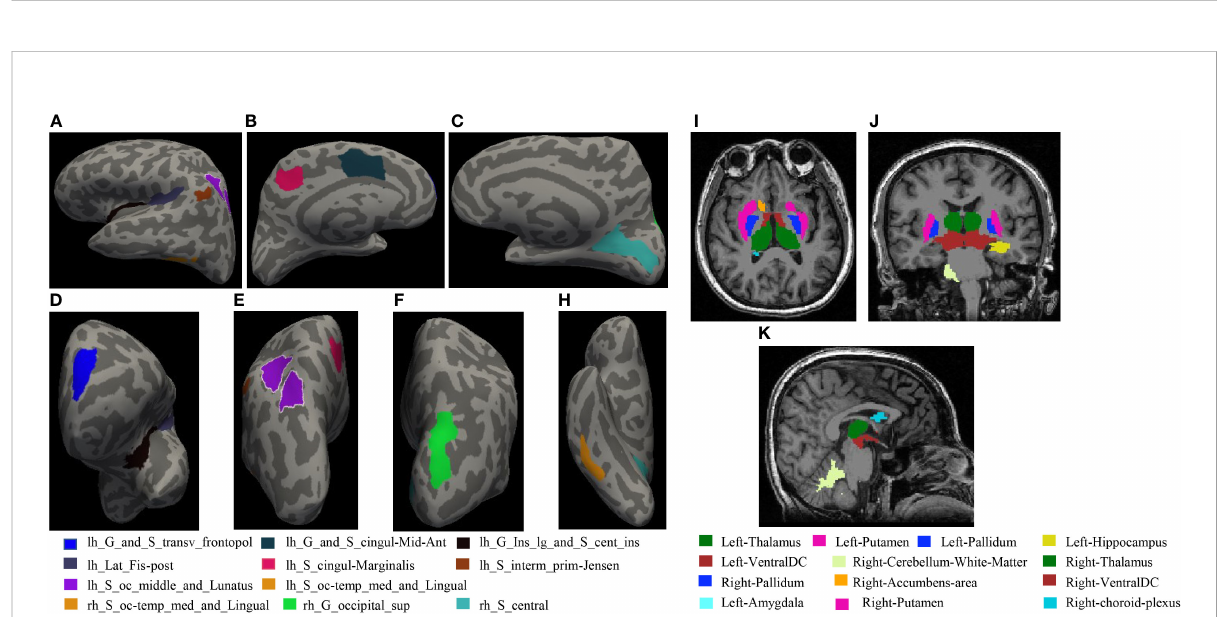
FIGURE 4 (A – H) shows statistical differences in the locations of cortical thickness: (A) Left hemisphere left side view; (B) Left hemisphere right side view; (C) Right hemisphere left side view; (D) Left hemisphere front view; (E) Left hemisphere rear view; (F) Right hemisphere rear view; H Right hemisphere bottom view. (I – K) The locations of subcortical structures with statistical differences: (I) : coronal, (J) : axial, (K) : sagittal.